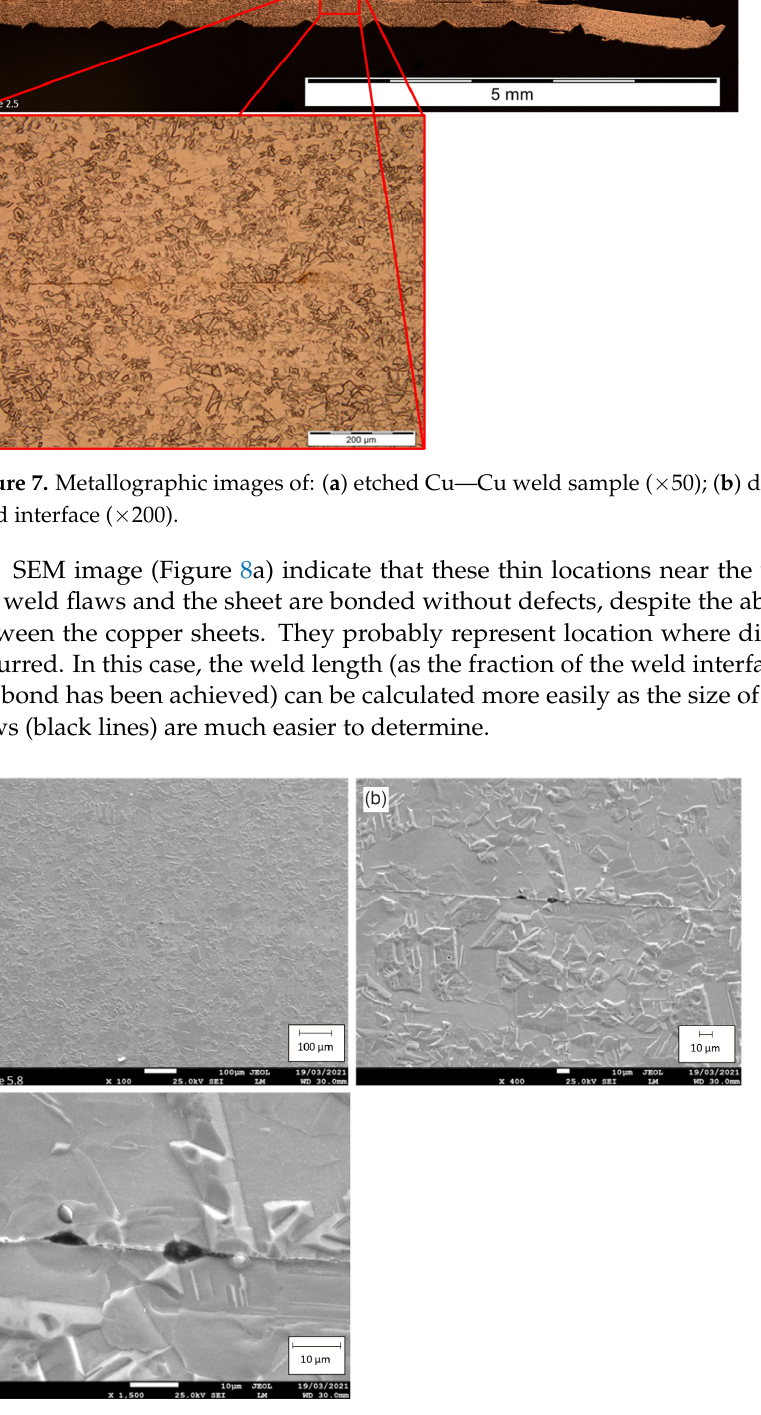
Figure 8. SEM image of porosities at ( a ) ×100; ( b ) ×400; ( c ) ×1500.